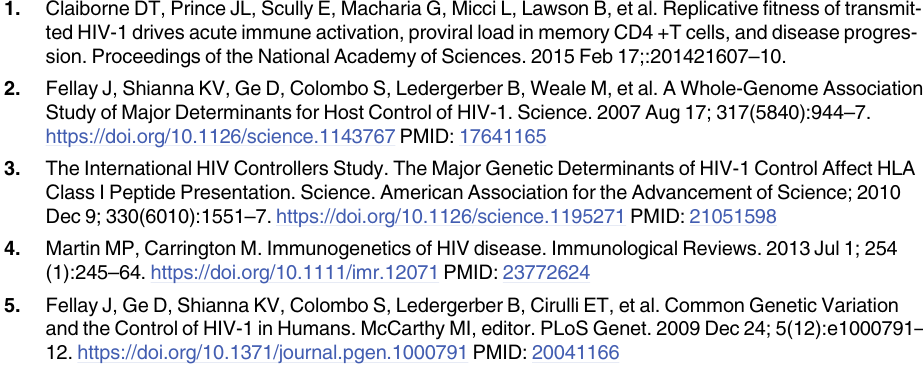
S4 Table. Associations between the levels of LPS and cellular immune activation are largely independent of plasma viremia at the time of PBMC